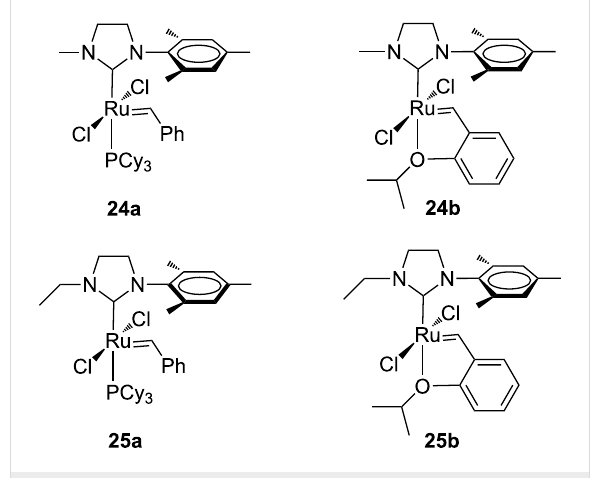
Figure 7: Grubbs ( 24a and 25a ) and Hoveyda-type ( 24b and 25b ) complexes with N -alkyl, N’ -mesityl